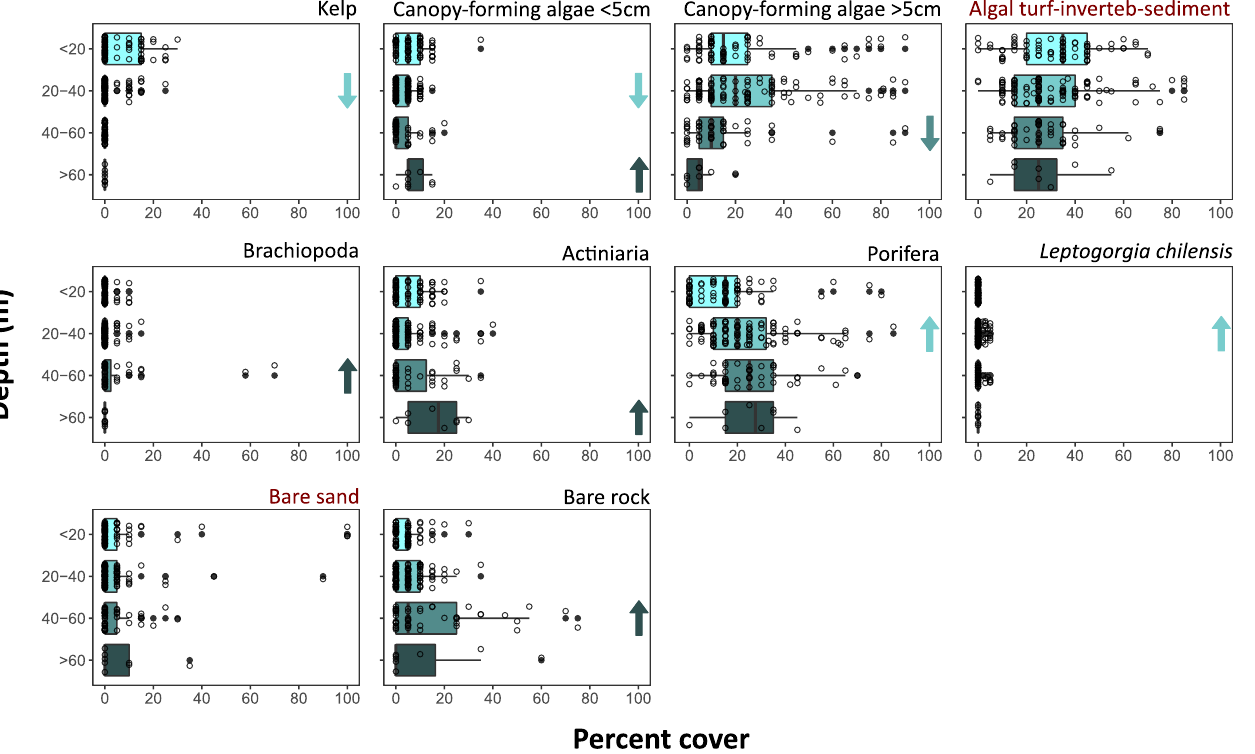
Figure 6. Percent cover of benthic taxa and bare sand or rock (available for colonisation) in depth strata. Points represent occurrences on quadrats; on boxplots: vertical lines indicate median value; boxplot hinges indicate first and third quartiles; boxplot whiskers indicate largest and lower values no further than 1.5 × inter-quartile range from the respective hinge; and data beyond the whiskers indicate outliers. Red highlights non-significant differences between depth strata (Kruskal–Wallis rank sum test, p -value < 0.05). Arrows indicate significant increases or decreases regarding the immediate shallower depth category as given by pairwise comparisons.